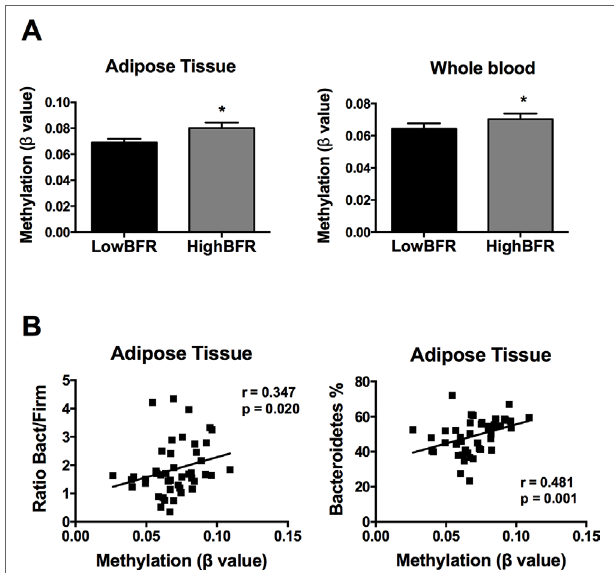
FIGURE 4 | Association between the DNA methylation status of insulin like growth factor 2 mRNA binding protein 2 (IGF2BP2) and the gut microbiota composition in obese subjects. (A) Methylation of IGF2BP2 ( β value) in the HighBFR vs. LowBFR groups in both visceral adipose tissue and whole blood. Data ( n = 10 per group) are plotted as means ± SE. Significance was tested using Mann–Whitney U test and is indicated as * p < 0.05. (B) Spearman correlations between IGF2BP2 methylation in visceral adipose tissue and the ratio Bact/Firm or the relative abundance (%) of